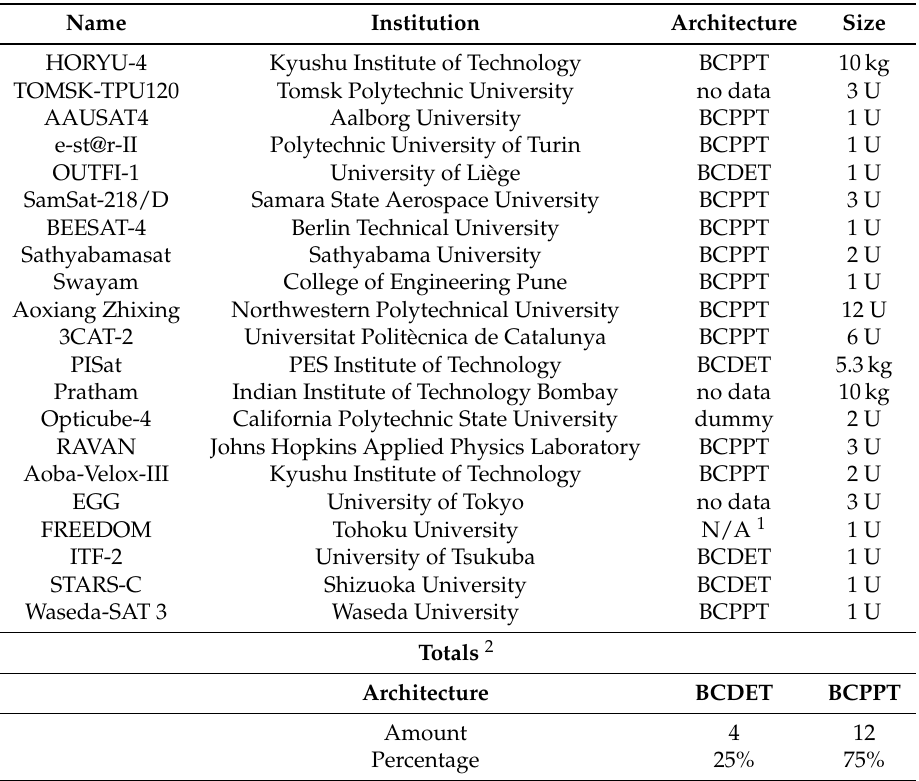
Table 3. University-class satellite launches in 2016.